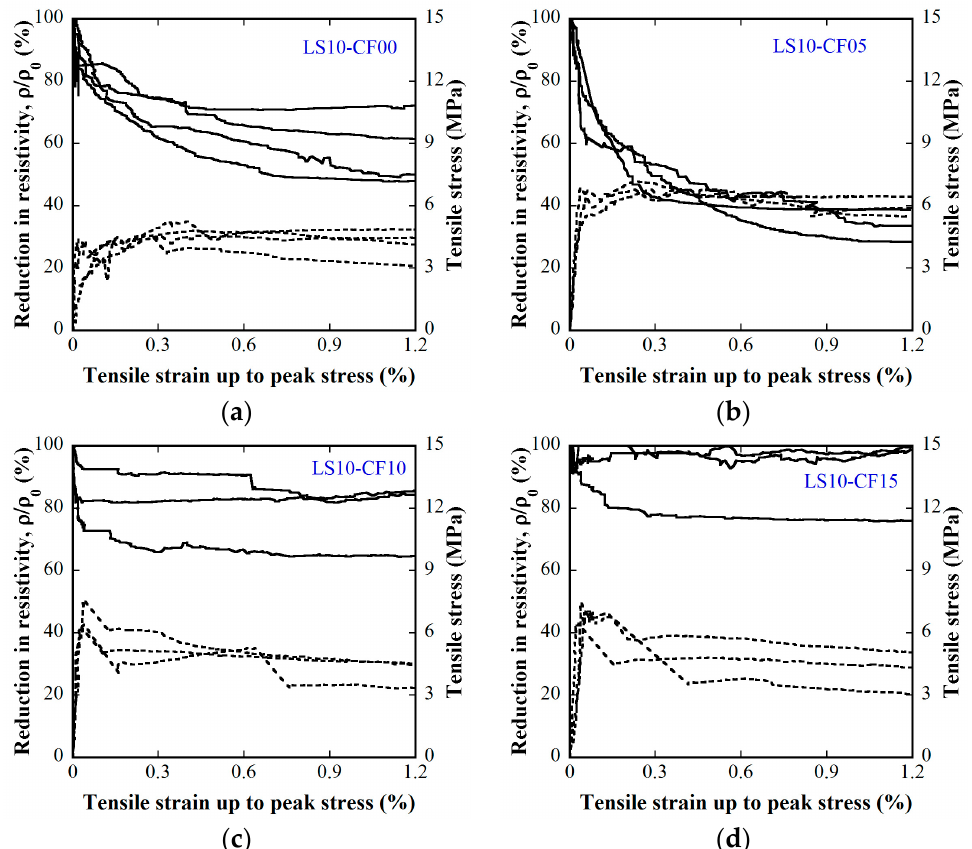
Figure 15. Influence of carbon fiber content on electro-tensile behaviors of MSFRC1 group (stress–strain: dashed curve, reduction in resistivity–strain: solid curve): ( a ) 1.0% smooth fibers & 0.0% carbon fibers; ( b ) 1.0% smooth fibers & 0.5% carbon fibers; ( c ) 1.0% smooth fibers & 1.0% carbon fibers; ( d ) 1.0% smooth fibers & 1.5% carbon fibers.